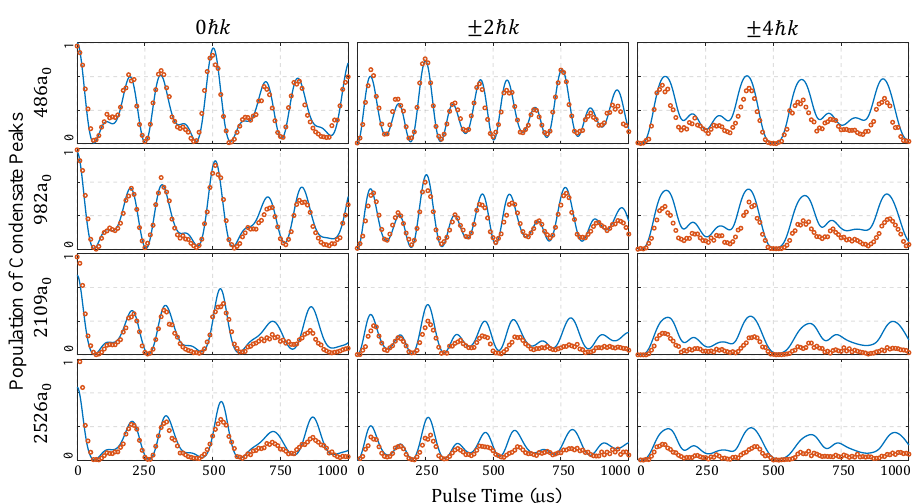
Figure 8: The population evolution of 0 ħ hk , ± 2 ħ hk , ± 4 ħ hk modes at different inter- action strengths (open symbols) with collision simulation results (solid line) for = 50 E U . The initial condition of the simulation is a product of the GPE calcu- r 0 lation multiply by the loss factor calculated from t = 60 µ s (Figure 7). Different from Figure 4(right), here we normalize to the initial condensate